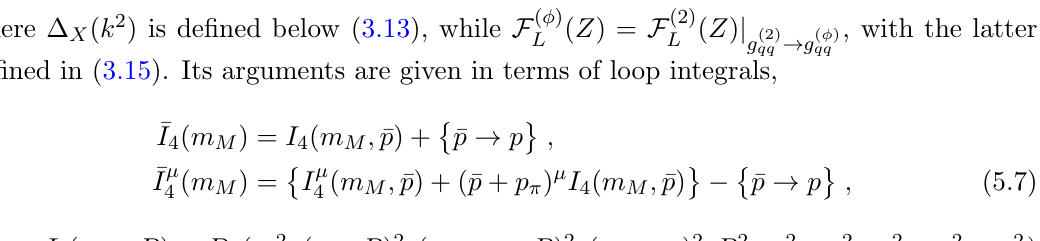
(cid:25) 0 1 (cid:22) 1 , as the notation !